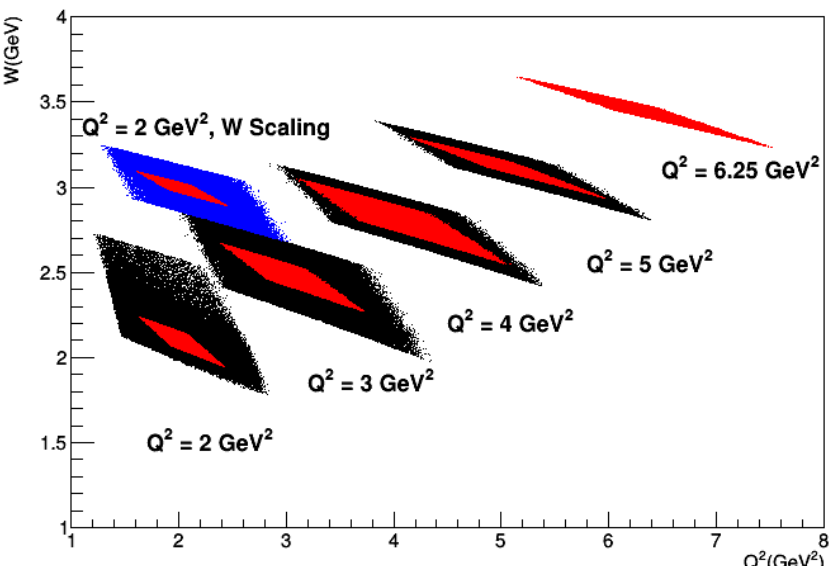
Figure 5. W vs. Q 2 diamonds for the Q 2 = 2.0, 3.0, 4.0, 5.0, and 6.25 GeV 2 settings of the Jefferson Laboratory proposal E12-20-007. The black diamonds are for the higher ε settings and the red diamonds are for the lower ε settings. The diamonds for the W scaling setting are shown separately (in blue and red). Note that there is only one ε setting for Q 2 = 6.25 GeV 2 . The overlap between the black and red diamond is critical for the L/T separation at each setting. The boundary of the low ε (red) data coverage will become a cut for the high ε data. See text for